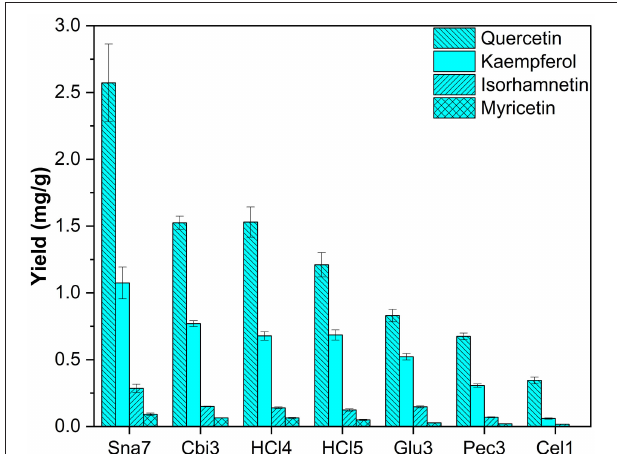
FIGURE 10 | Aglycone yields (mg/g) from leaf extracts of Q. robur . Enzymatic hydrolysis (25min): Sna7: 5mg snailase (pH 5.5, 37 ◦ C); Cbi3: 5U cellobiase (pH 4.5, 37 ◦ C); Glu3: 20U β -glucosidase (pH 5.5, 37 ◦ C); Pec3: 20U pectinase (pH 4.5, 40 ◦ C); Cel1: 20U cellulase (pH 5.5, 52 ◦ C). Acidic hydrolysis (60min): HCl4: 2M HCl at 70 ◦ C; HCl5:1M HCl at 100 ◦ C ( n = 3 ± SD).